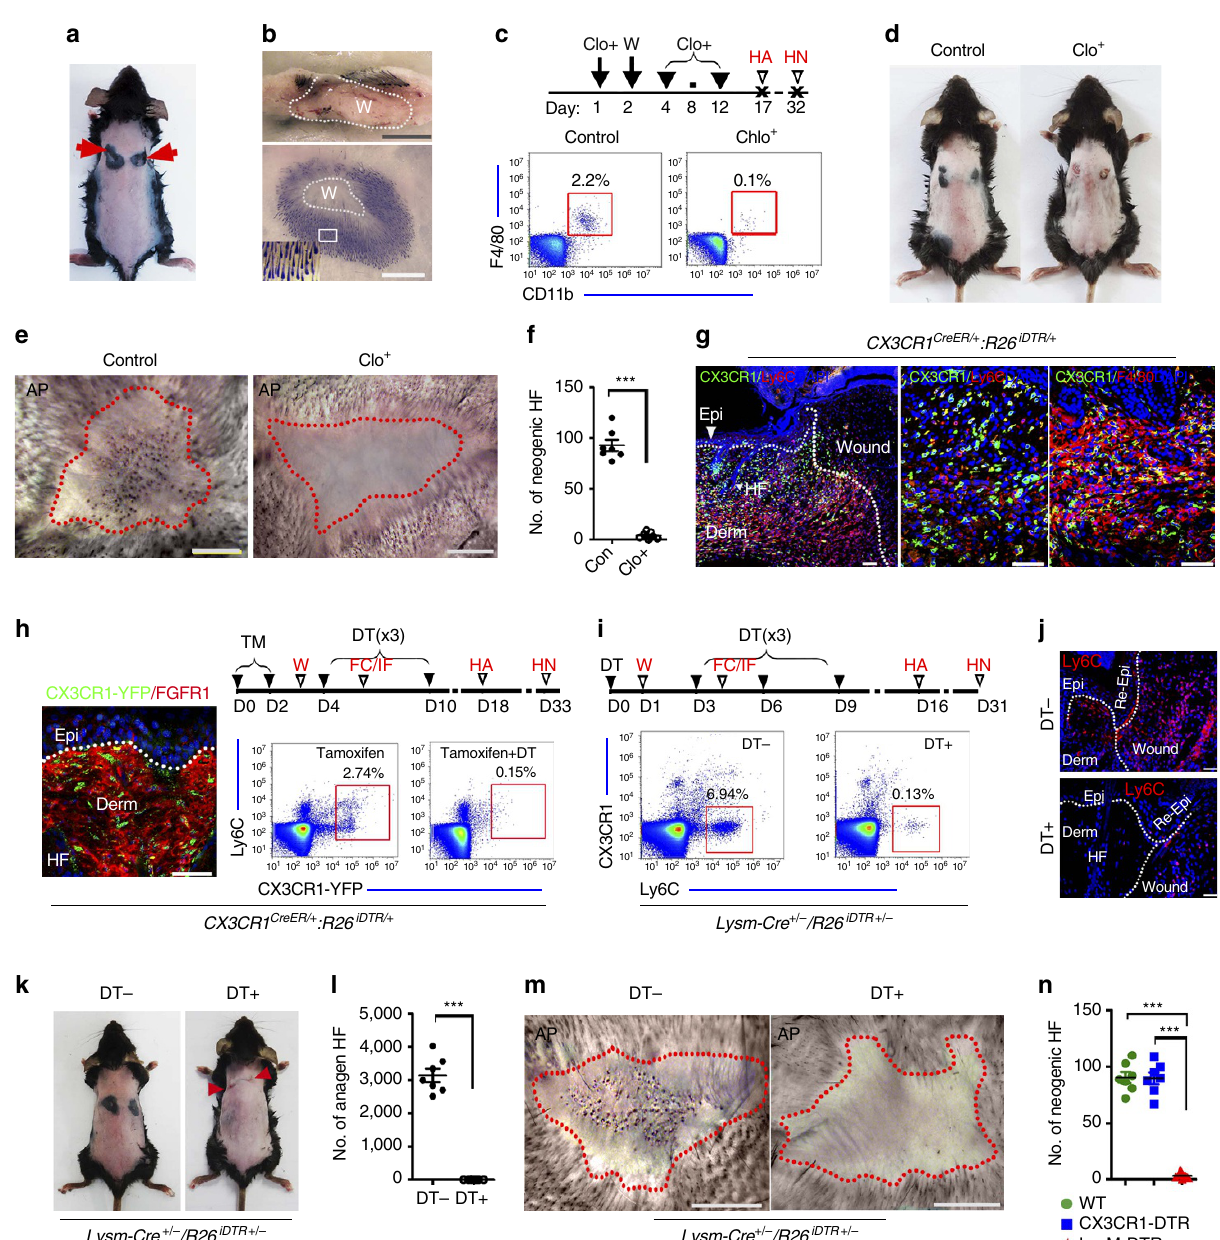
Figure 1 | Ly6C þ inflammatory macrophages contribute to WIH-A and WIHN. ( a ) Wounding the skin of 8-week-old mice induced a transition of HF from the telogen phase to the anagen phase around wound areas. n ¼ 56. ( b ) The longitudinal section of the wound at the 15th day post-wound (PWD-15) (upper panel) and of the dermal side of the skin showed the pigmented anagen HFs around the wound (lower panel). ( c ) Flow cytometry analysis of wound tissue single cell suspensions showed the extensive depletion of F4/80 þ /CD11b þ macrophages after clodronate liposome (Clo) treatment. Mice receiving clodronate, n ¼ 7; control mice, n ¼ 12. ( d ) WIH-A analysis in Clo treated ( n ¼ 8) and the control mice ( n ¼ 11). ( e , f ) Clo treatment resulted in complete elimination of WIHN ( n ¼ 7) ( e ), and the number of neogenic HFs in the two groups of mice was quantified ( f ). ( g ) Immunofluorescence (IF) analysis of wound tissue showed the infiltration of both Ly6C þ inflammatory macrophages and CX3CR1 þ resident macrophages at PWD-3. For all IF analyses, representative images from 8 to 16 tissue sections of wounds in 4–6 mice are shown. ( h ) IF image showed CX3CR1-YFP cells (green) in the dermis of the normal skin of CX3CR1 CreER / þ :R26 iDTR / þ mice. Flow cytometry analysis indicated that TM and DT treatments depleted over 90% of CX3CR1-EYFP cells in the blood of CX3CR1 CreER / þ :R26 iDTR / þ mice ( n ¼ 9). ( i ) Flow cytometry analysis showed that the DT treatments depleted over 95% of Ly6C þ cells in the blood of LysM-Cre:R26 iDTR/ þ mice ( n ¼ 9). ( j ) IF staining of Ly6C þ macrophages in the wound tissue (PWD-3) of LysM-Cre:R26 iDTR/ þ mice with or without DT treatment. ( k , l ) Treatment of LysM-Cre:R26 iDTR/ þ mice with DT resulted in the complete inhibition of WIH-A. n ¼ 8 for DT- mice; n ¼ 10 for DT þ mice. ( m , n ) Deletion of Ly6C þ macrophages resulted in no neogenic HF in the wound ( n ¼ 7), but the deletion of CX3CR1 þ macrophages showed no obvious effect on the number of neogenic HF ( n ¼ 8 mice). W, wound; HA, hair follicle anagen analysis; HN, hair follicle neogenesis analysis; TM, tamoxifen; DT, diphtheria toxin; WT, wild type. Scale bars, 50 m m. Data are expressed as the mean ± s.e.m. *** P o 0.005, unpaired t -test, two-tailed.